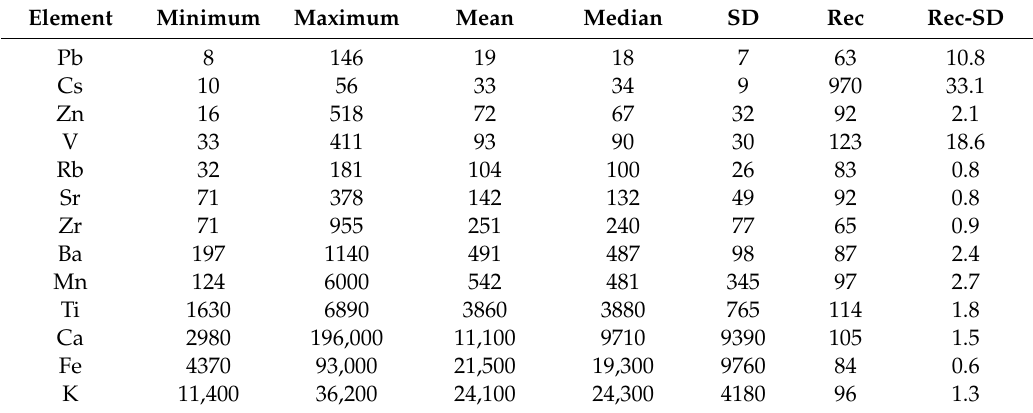
Table 2. Descriptive statistics of the elements used for modelling after removal of samples with “not a number” (NaN) classification in any of the elements included (n = 1520). Minimum, maximum, mean, median, and standard deviation (SD) are presented as mg kg − 1 , where values < 1000 were rounded to the closest integer and values > 1000 to three significant digits. Rec = mean recovery rates from four measurements based on reference standard 2709a from the National Institute of Standards and Technology (NIST) (%); Rec-SD = standard deviation of the four recovery rates (%). Element